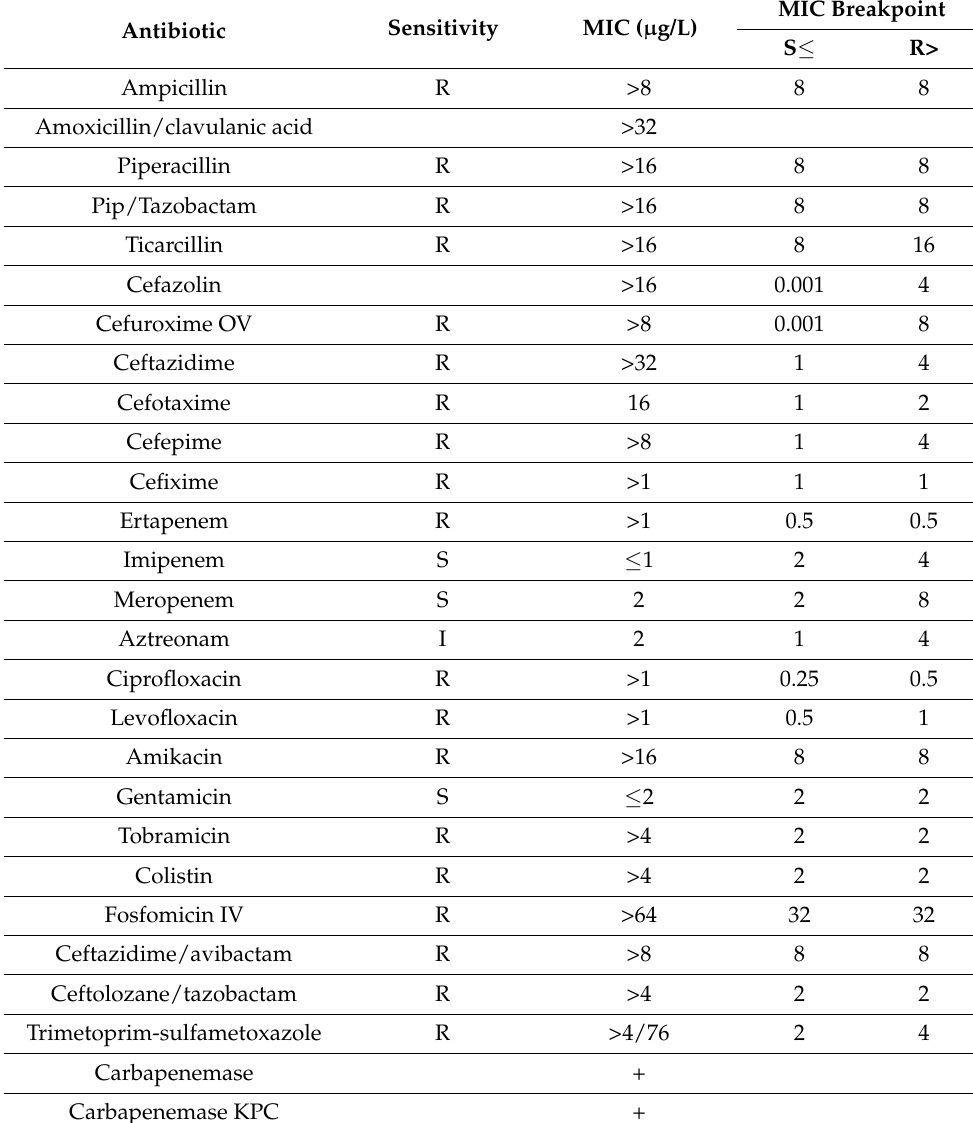
Table 1. Susceptibility profile of mutant